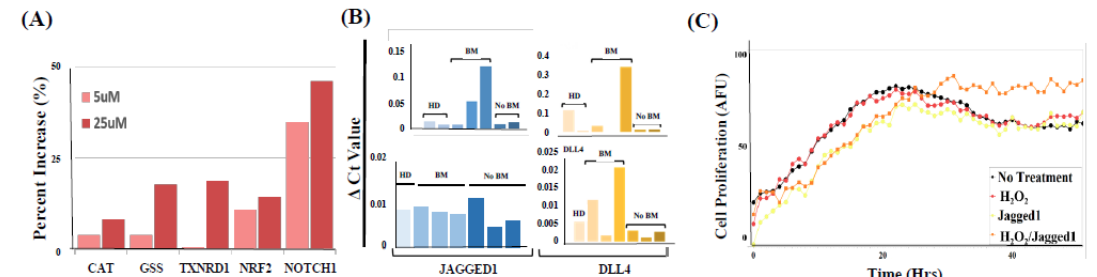
Figure 7. ( A ) Dose-dependent increase of NRF2 target genes in melanoma CTCs following H 2 O 2 treatment. Data from a representative experiment ( n = 4) are shown. ( B ) Augmented gene expression of Notch1 ligands Jagged1 and DLL4 in PMN-MDSCs isolated from patients with / without brain metastasis (BM). HD = corresponding analyses of PMN-MDSCs isolated from blood of healthy donors. ( C ) CTC proliferation is up-regulated by the combinatorial treatment of oxidative stress and MDSC Jagged1 measured by real-time IncuCyte ® Live-Cell Analysis System in 3D cell conditions. No treatment (negative control; black), H 2 O 2 (25 µ M; red), recombinant human Jagged1 (100 µ M; yellow), and combinatorial (orange) are shown. Data are representative of six independent experiments ( n = 6).